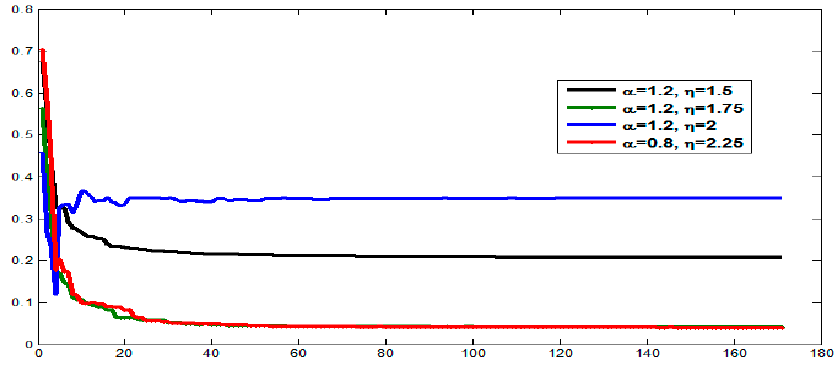
Figure 7. Comparison of reconstruction errors with different choices of parameters of GFCMs.